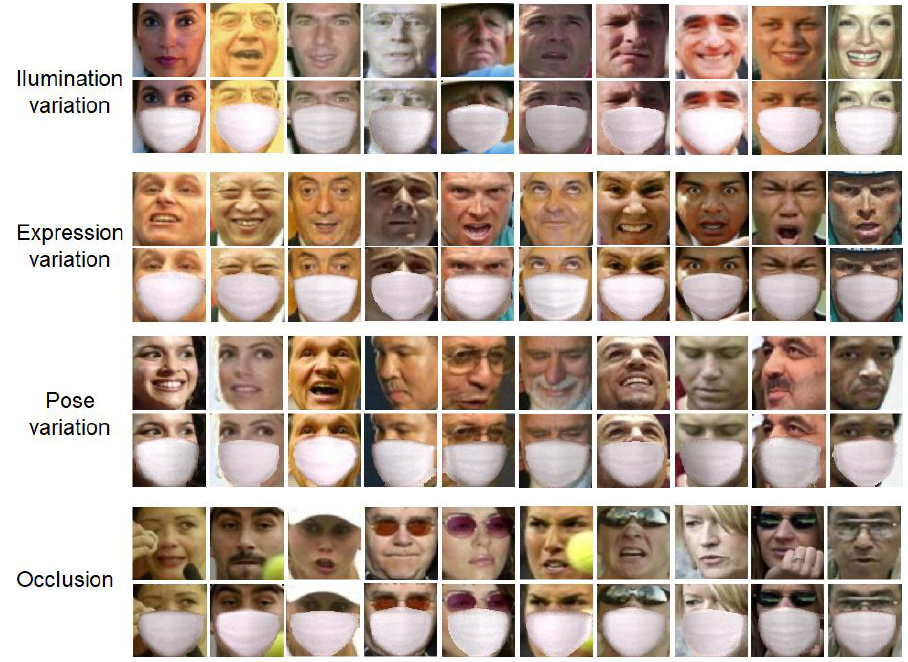
Figure 11. Results for the proposed masked face synthesis on LFW database. The results were categorized into four different challenges.